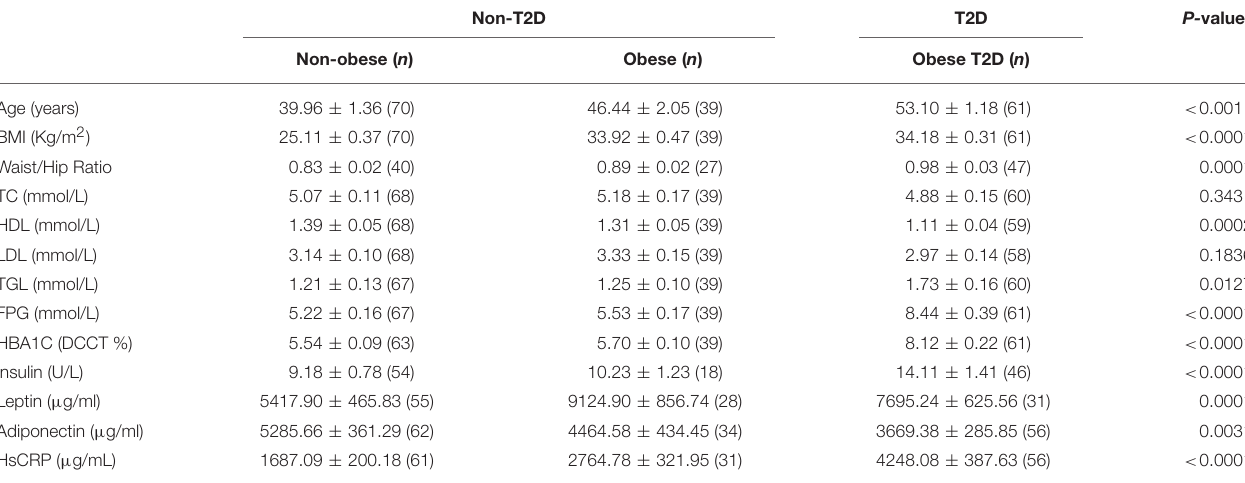
TABLE 4 | Demographics and characteristics of non-obese non-T2D, obese non-T2D, and obese T2D subjects.